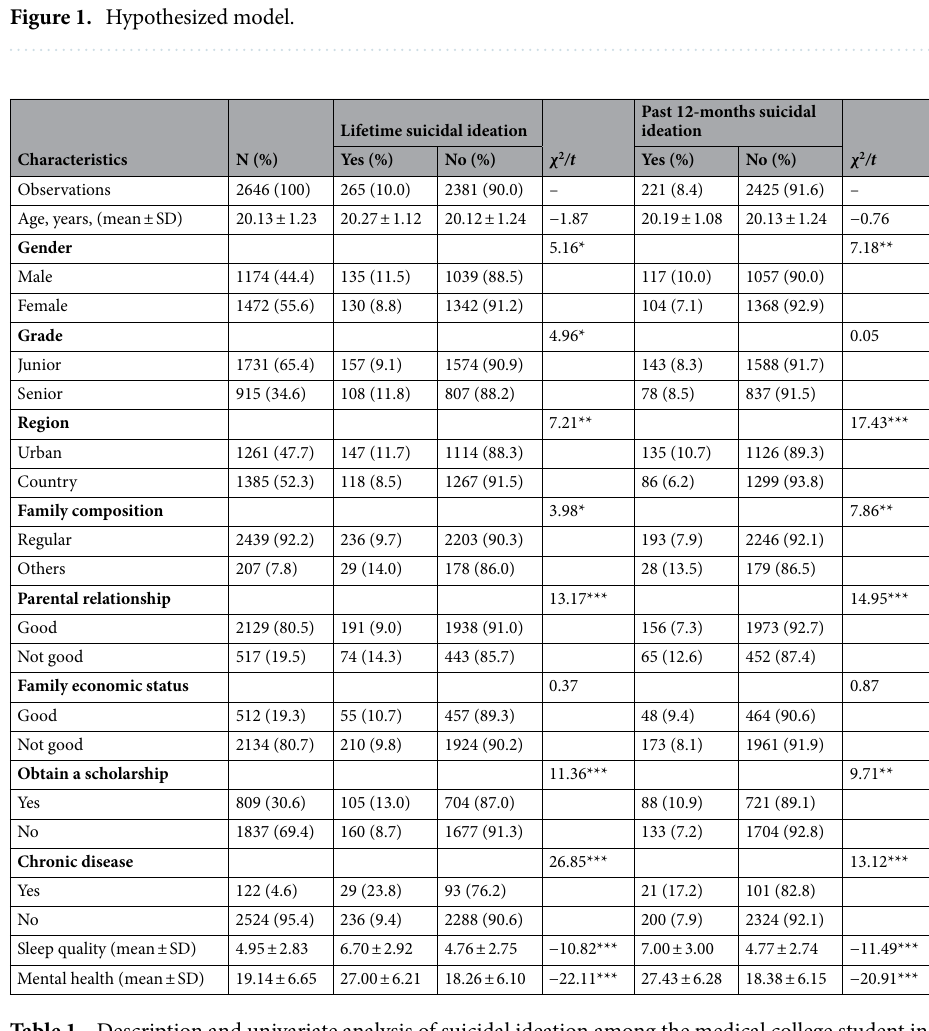
Binary logistic regression analysis for the lifetime SI risk among the medical college stu - dents. In Table 2, we conducted five models (Models 1 to 5) to identify the relationship between chronic diseases, sleep quality, mental health, and lifetime SI among the medical college students. After controlling for the significant background characteristics, the former three variables were entered step-wise into the logistic regression models. First, chronic diseases and sleep quality were separately added into Models 1 and 2, respec- tively; the former [odds ratio (OR) = 2.68, 95% confidence interval (CI) 1.71–4.19] and the latter (OR = 1.24, 95% CI 1.19–1.30) were significantly related to lifetime SI. Second, they were collectively included in Model 3; chronic diseases (OR = 2.13, 95% CI 1.34–3.38) and self-reported sleep quality (OR = 1.23, 95% CI 1.18–1.29)